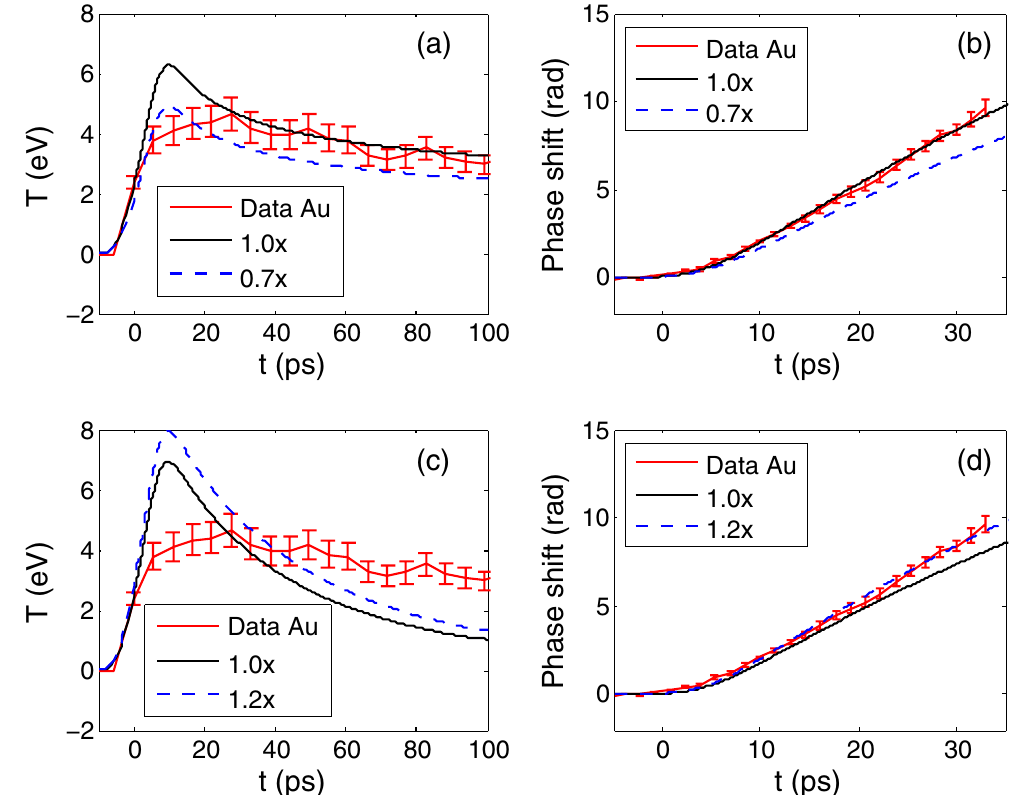
Figure 2. Comparison of data for Au-only targets and HYDRA simulation outputs to constrain the Au EOS. The time history of the temperature is from SOP and the phase shifts is from FDI measurements. ( a ) and ( b ) show results using LEOS L790, and ( c ) and ( d ) using Sesame table 2700 for Au EOS. The number in the legend is a multiplier in the proton heating